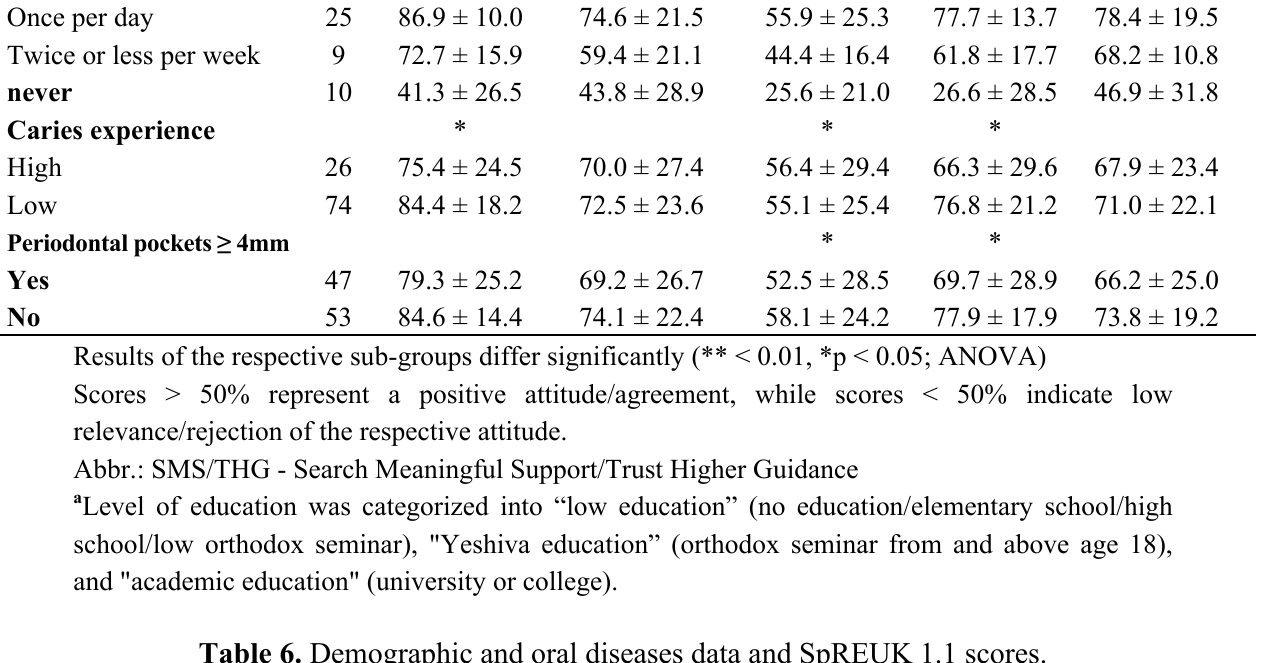
Table 6. Demographic and oral diseases data and SpREUK 1.1